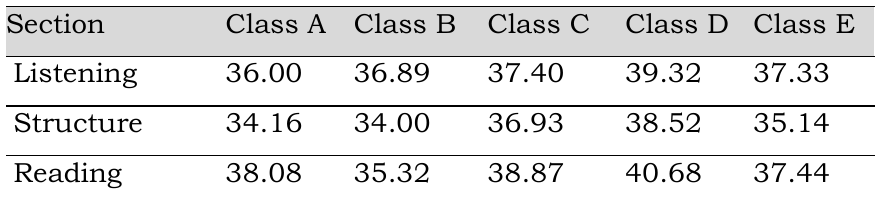
Table 1. Mean of TOEFL Pretest